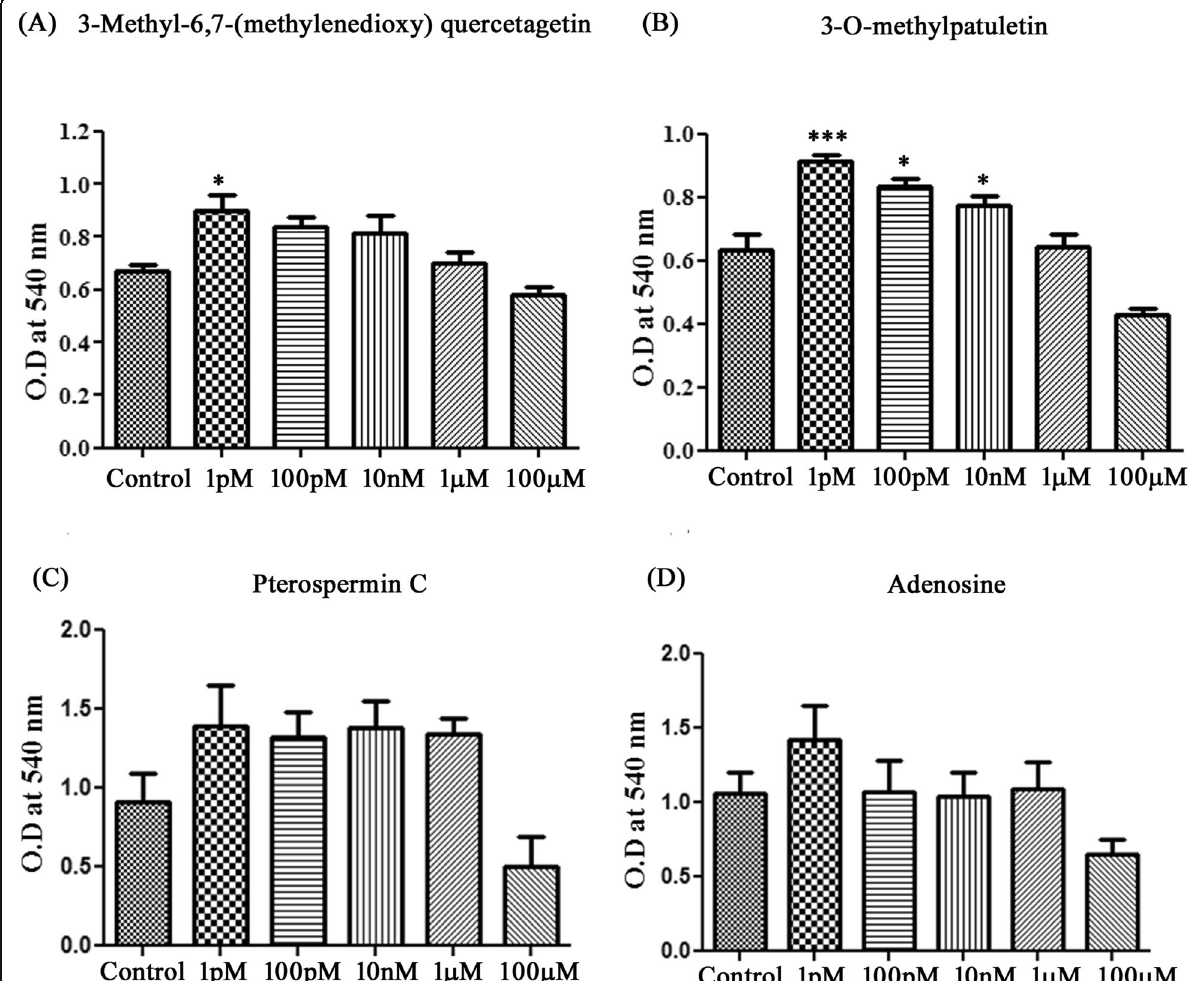
Fig. 5 MTT assay of isolated compounds depicting effect on cell viability. Cells were cultured in differentiation medium and treated with various concentrations of the compound ranging from 100pM to 1 mM for. The percent viable cells were calculated as compared to untreated cells taken as control. a 3-Methyl-6,7-(methylenedioxy) quercetagetin (K007) ( b ) 3-O-methylpatuletin (K008) ( c ) Pterospermin C (k009) ( d ) Adenosine (K010). Data shows Mean ± S.E.M of three independent experiments ***p < 0.001; **p < 0.01 and *p < 0.05 as compared with untreated cells